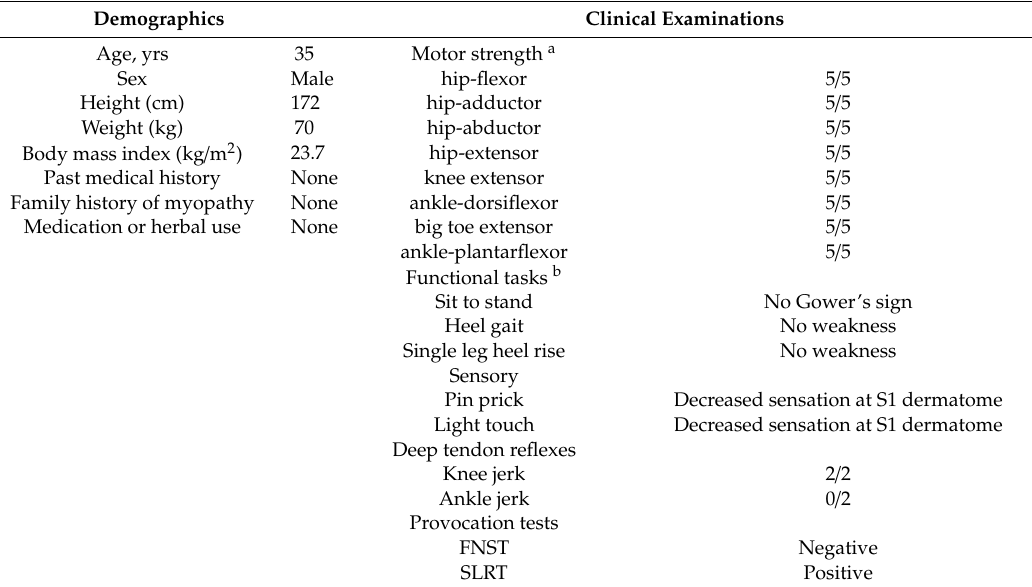
Table 1. Summary of demographics and clinical examination